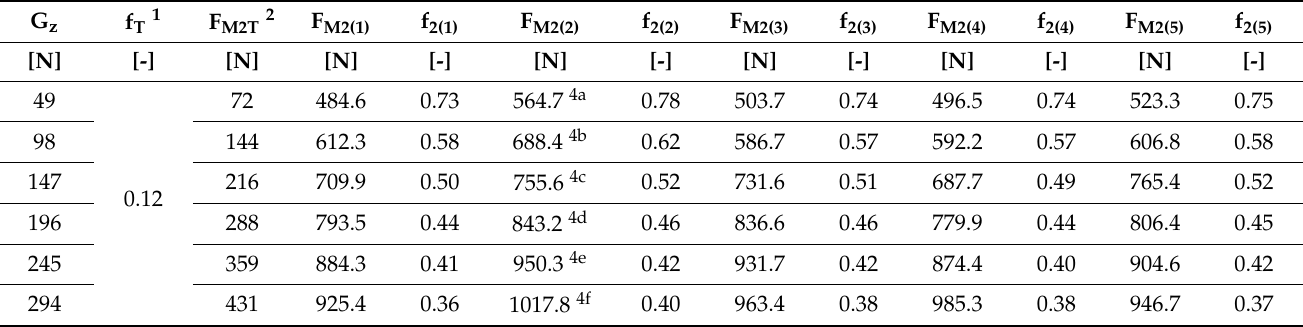
Table 3. Tensile force F M2(i) [N] for i = 1 ÷ 5, φ 8 mm rope, semi-circular groove, clean